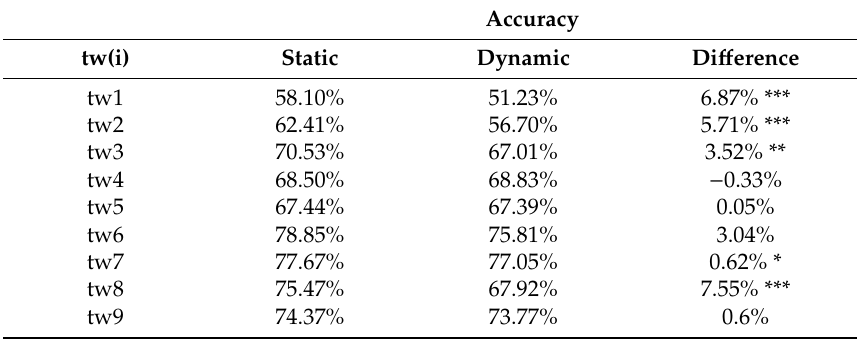
Table3. Thedi ff erencebetweenstaticanddynamicstimulationsonaccuraciesatdi ff erenttimewindows.